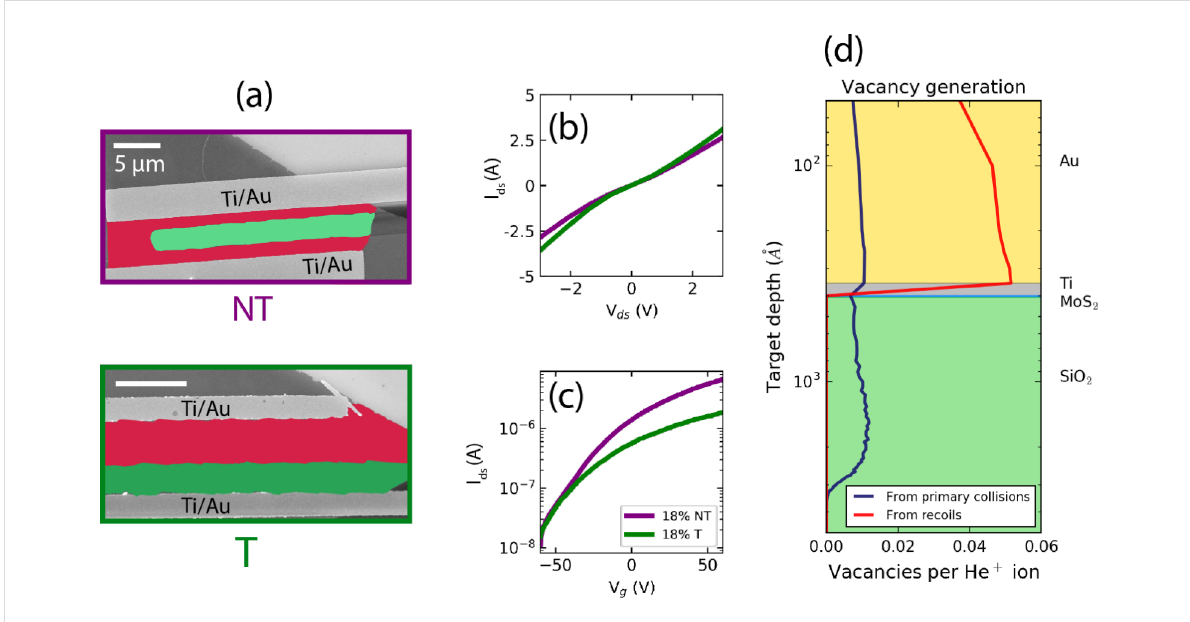
Figure 3: (a) Example SEM images of electrode non-touching (NT) and touching (T) devices with a similar I R . The colored green area is the channel region damaged by the He + ion beam, while the red area is the non-irradiated MoS 2 channel. Scale bars are both 5 μ m. (b) Output and (c) transfer curves of devices with I R = 18% from the NT and T categories, highlighting the deleterious effect of electrode irradiation on the current injection. (d) Simulation of the S vacancy yield generated as the He + ion beam penetrates the device at the contact stack, indicating damage to the metal–semi- conductor